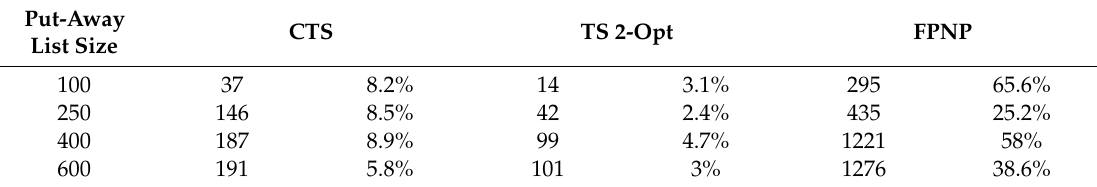
Table 6. Time savings (seconds) and percentage savings (%) by